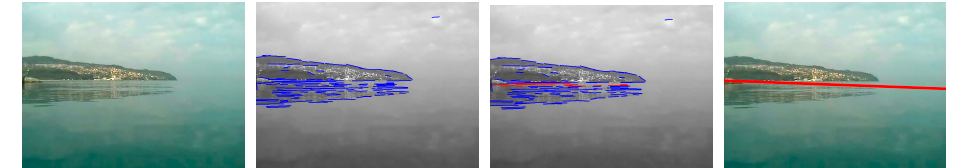
Figure 13. The performance of this CFS method on the very blurry horizon line. The first column